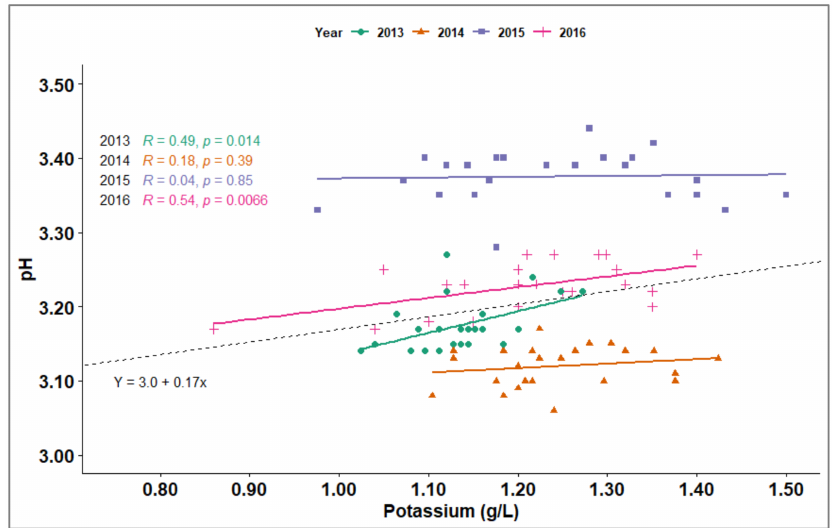
Figure 4. The relation between grape juice pH and K concentration for Glera vines over 4 study seasons. Within each year, a data point represents the means of 6 replicate vines for every treatment. The dotted line represents the mean regression line for all